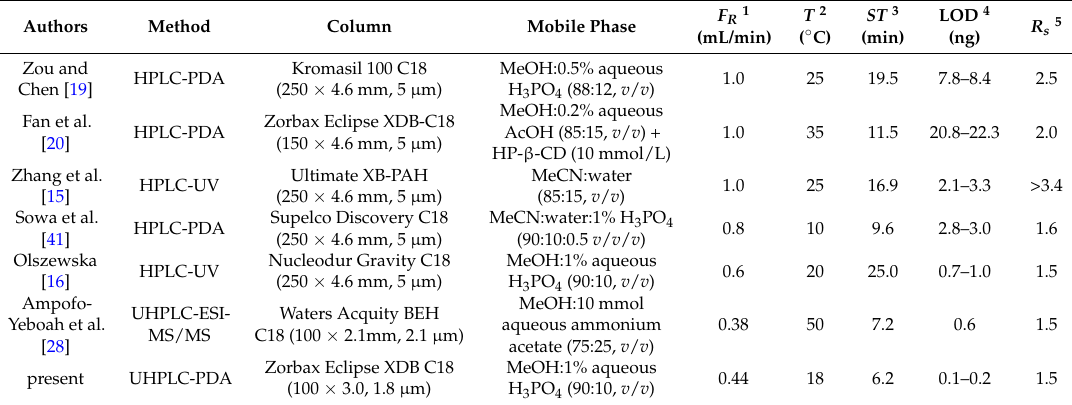
Table 5. Comparison of selected methods of OA (oleanolic acid) and UA (ursolic acid) separation.